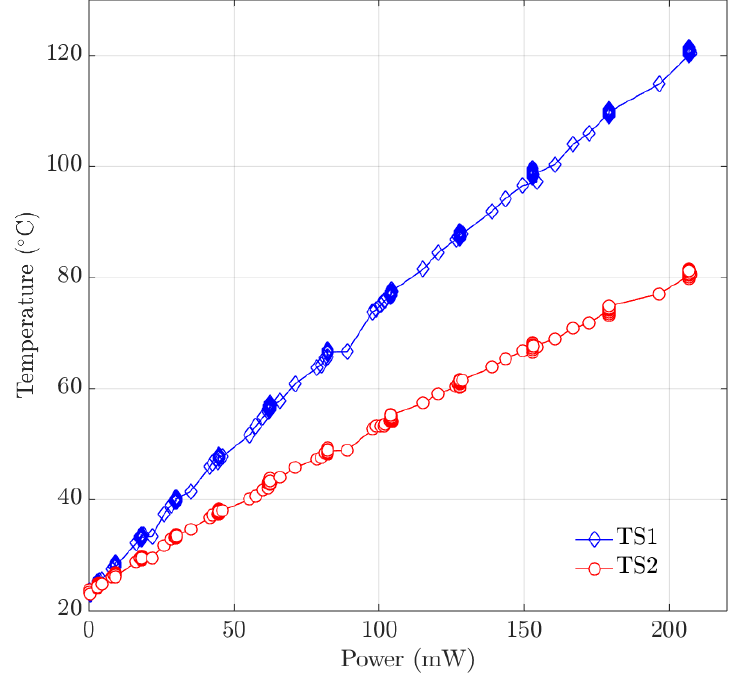
Figure 12. Joule heating result of the silicon microheater in the demonstrator